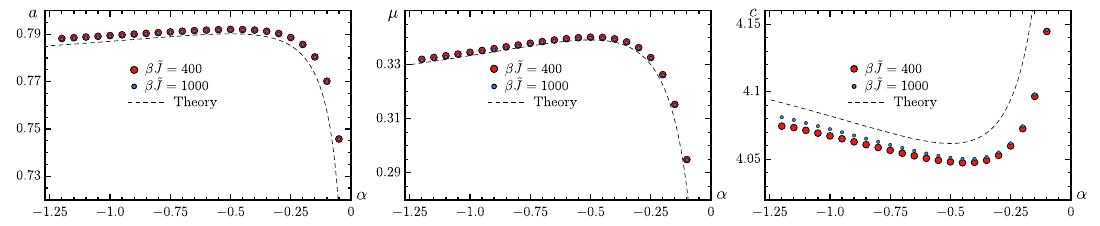
Figure 16 . a, µ, c as a function of α . Black dashed line: analytical answer obtained by solving the algebraic system (D.10), (D.15), (D.16), (D.17) numerically. Dots: numerical solution of DS equations. Red dots is β ˜ J = 400 , blue dots is β ˜ J = 1000 . In both plots ˜ J = 1 . Open